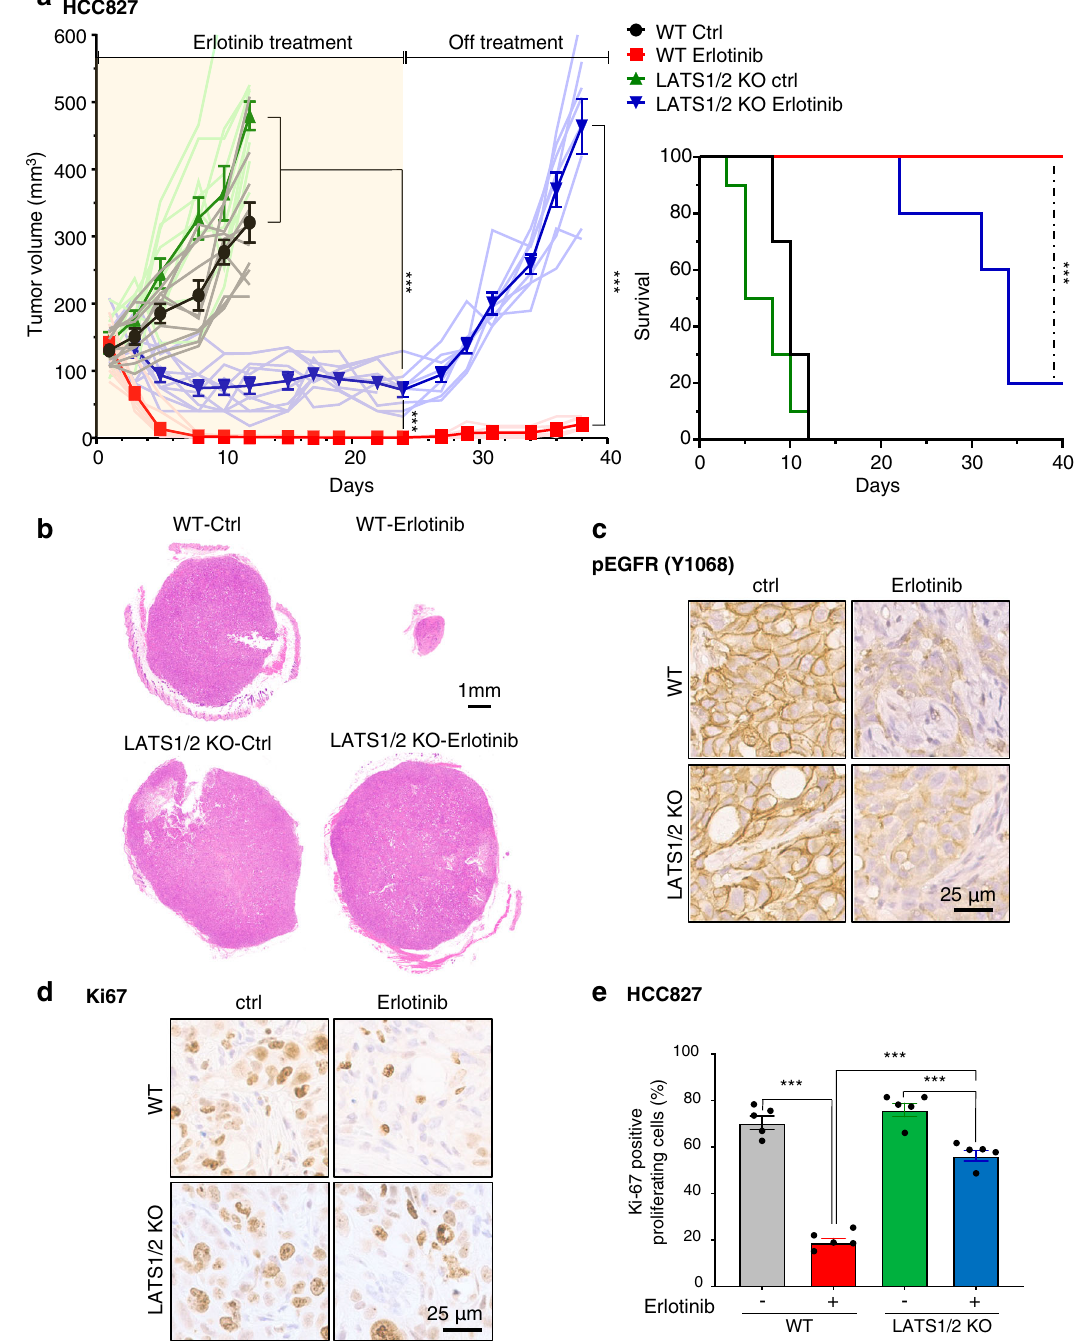
Fig. 7 Loss of LATS1/2 confers resistance to erlotinib treatment in cancer cells with EGFR alterations in vivo. a (left) Individual and average (bold line) growth curves for HCC827 control and LATS1/2 KO cells transplanted into Female NOD-scid IL2Rgamma null mice and treated with erlotinib for 24 days. ( n = 10 per group). Tumor re-growth was monitored after erlotinib treatment was discontinued. (right) Kaplan – Meier curve showing survival of mice from ( a ). The death of animals occurred either naturally, when tumor growth compromised animal welfare, or when tumor volume reached >200% of initial size at day 1 of treatment. ( n = 10 mice per group; Log-Rank/Mantel – Cox test.). b Representative histological sections from each treatment group. Scale bar represents 1 mm. c , d Representative immunohistochemical analysis of pEGFR and Ki67 in the short-term treatment groups (every day for 5 days). e Quanti fi cation of ( d ) showing percentage of cells staining positive for Ki67 ( n = 5 mice per group). Mean±SEM ( a , e ); *** P < mouse or anti-rabbit IgG at 1:20,000 dilution, Southern Biothech) diluted by 5% The concentration of supernatants was measured. Equal amounts of protein were non-fat milk in TBS-T buffer for 1 h at room temperature. Immobilon Western loaded for SDS-PAGE, and transferred to PVDF membranes. The membranes were Chemiluminescent HRP substrate (Millipore, MA) was used for detection. For blocked with 3% BSA in TBS-T buffer for 20 min. Then, the membranes were immunoprecipitation, cells were lysed in CHAPS buffer (1% CHAPS, 30mM Tris- incubated with primary antibodies diluted by 3% BSA or 5% non-fat milk in TBS-T buffer for 2h at room temperature. After washing by TBS-T buffer 3 times, the membranes were incubated with secondary antibodies (HRP-conjugated goat anti-